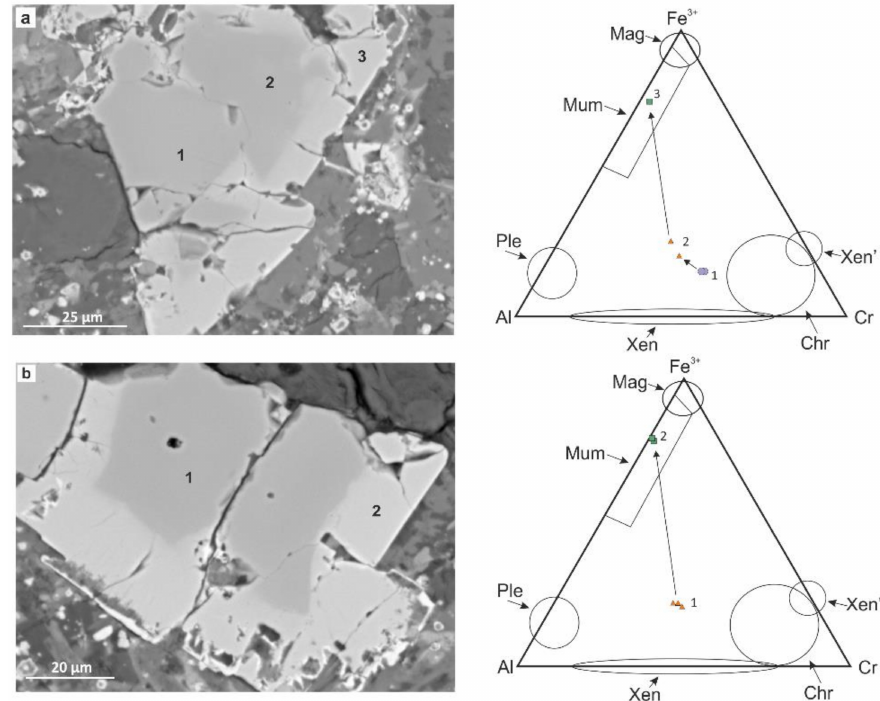
Figure 8. BSE images of zoned crystals and Al-Fe 3+ -Cr diagrams for spinels from Chuktukon